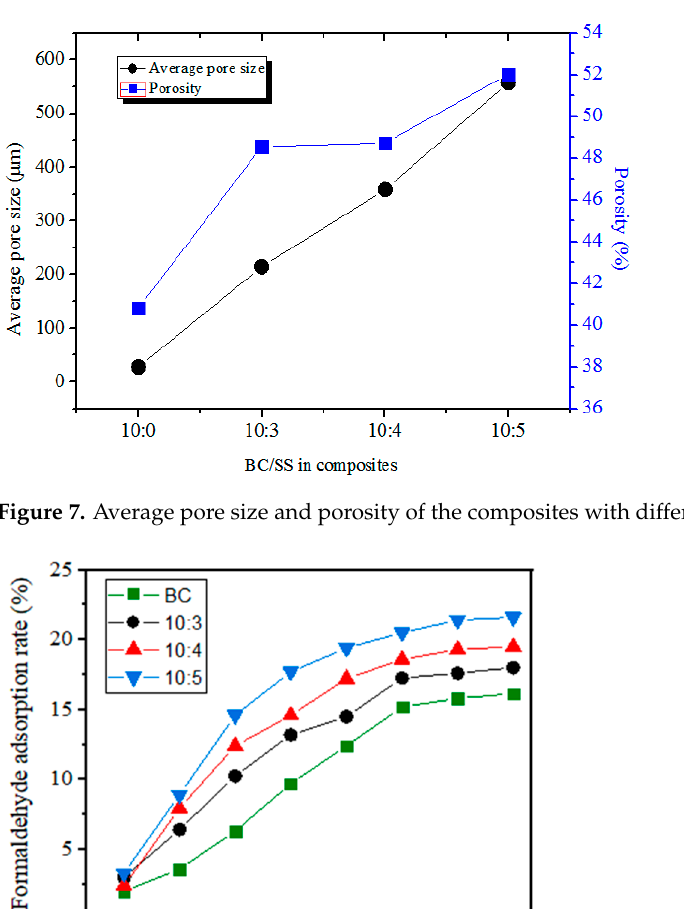
Figure 7. Average pore size and porosity of the composites with different BC/SS.